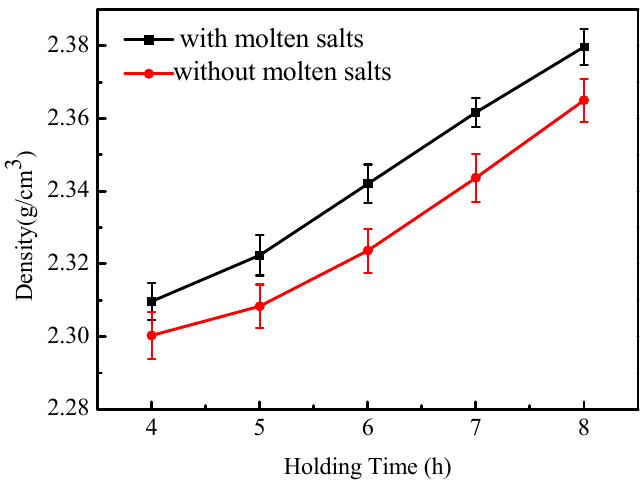
Figure 4. The density of monolithic geopolymer ceramics at different holding times.